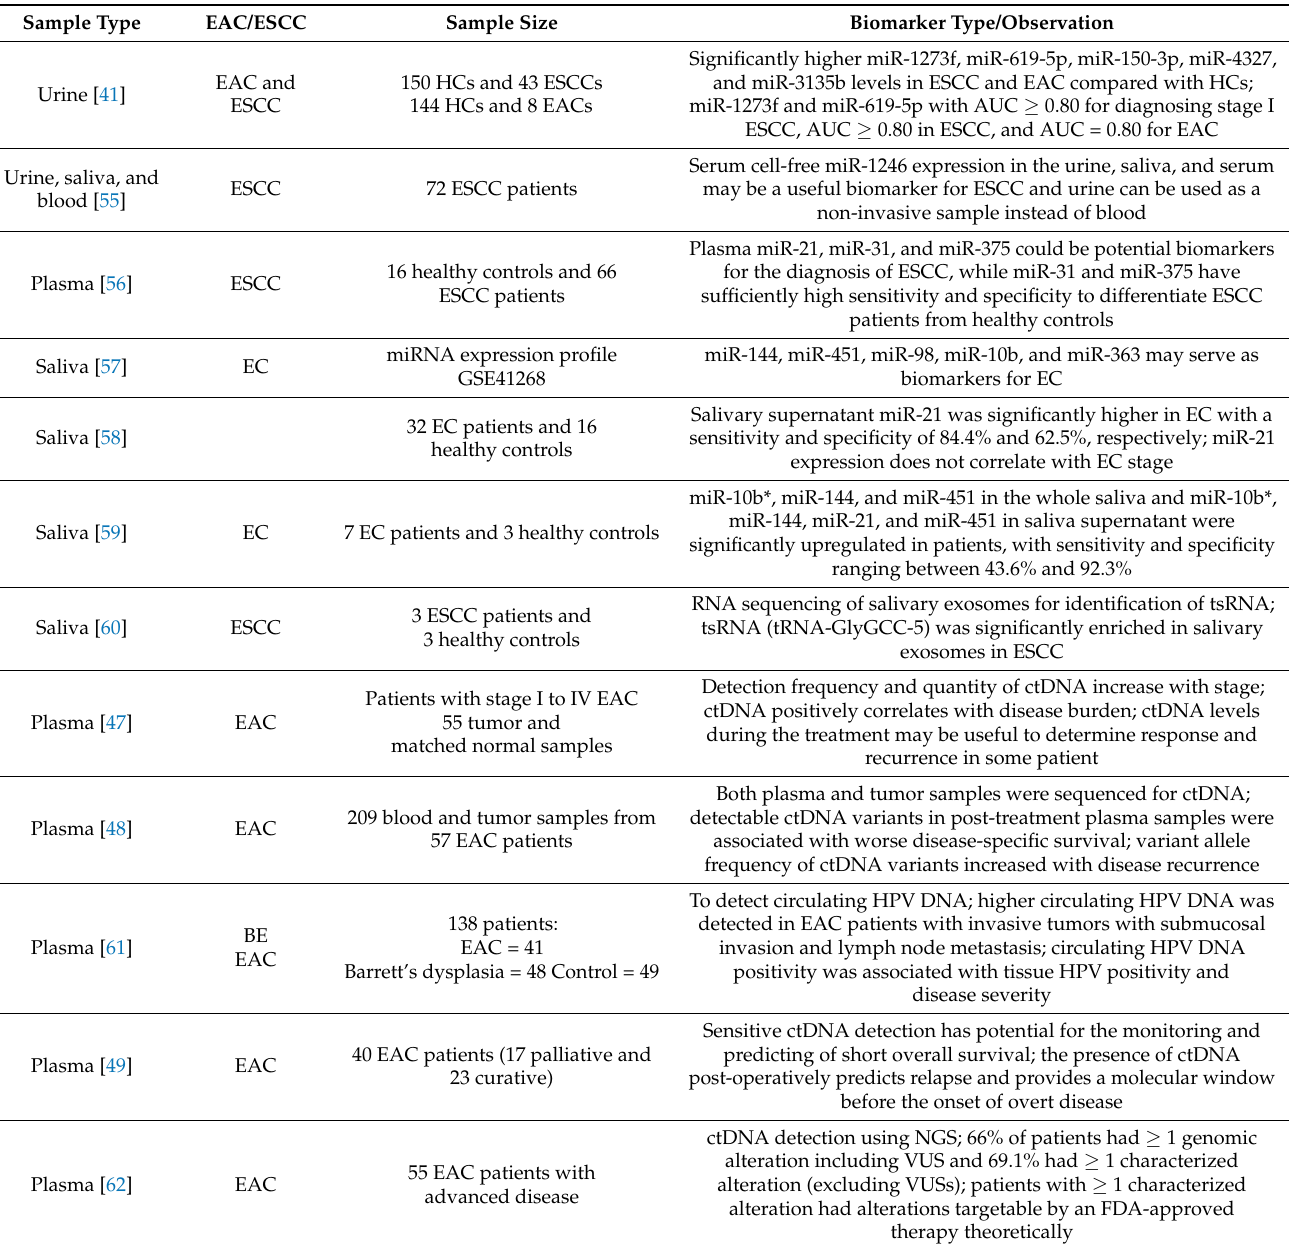
Table 2. Molecular biomarkers for ESCC and EAC. Area under the curve (AUC), esophageal